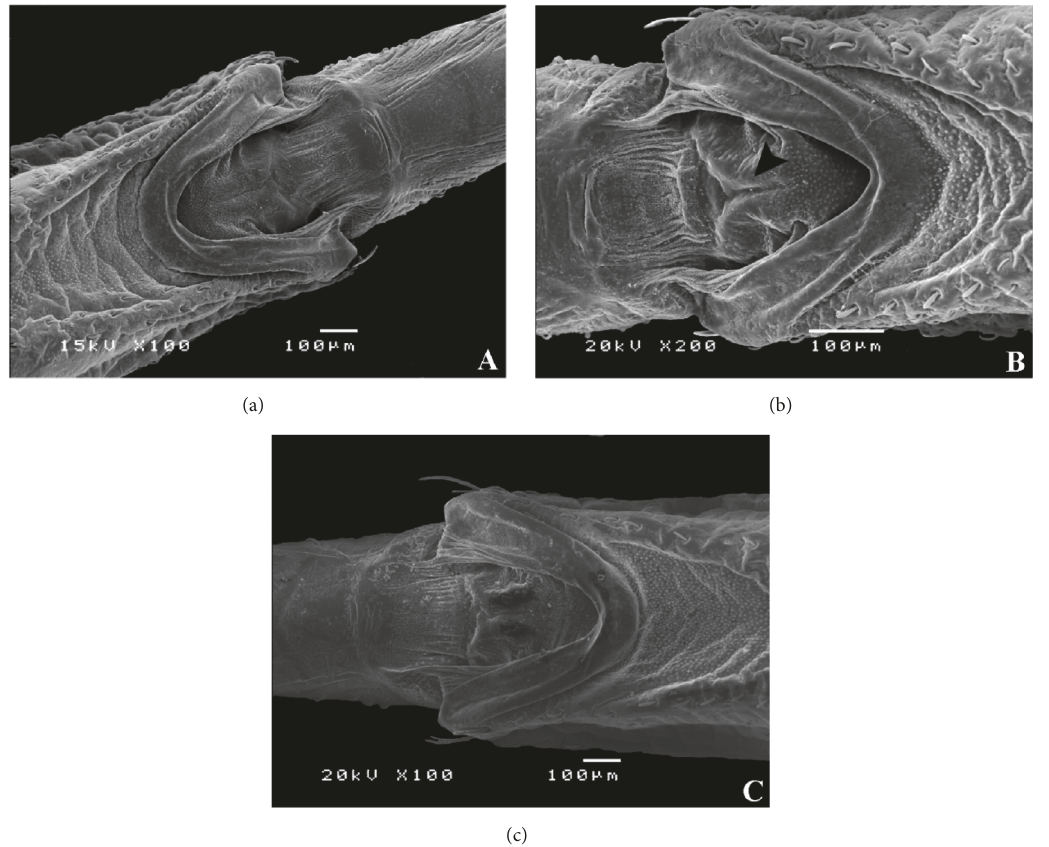
Figure 1: Micrography of the buccula. (a) Triatoma carcavalloi male (U-shaped) . (b) Triatoma circummaculata male (V-shaped). (c) Triatoma rubrovaria male (U-shaped). Rift (arrow